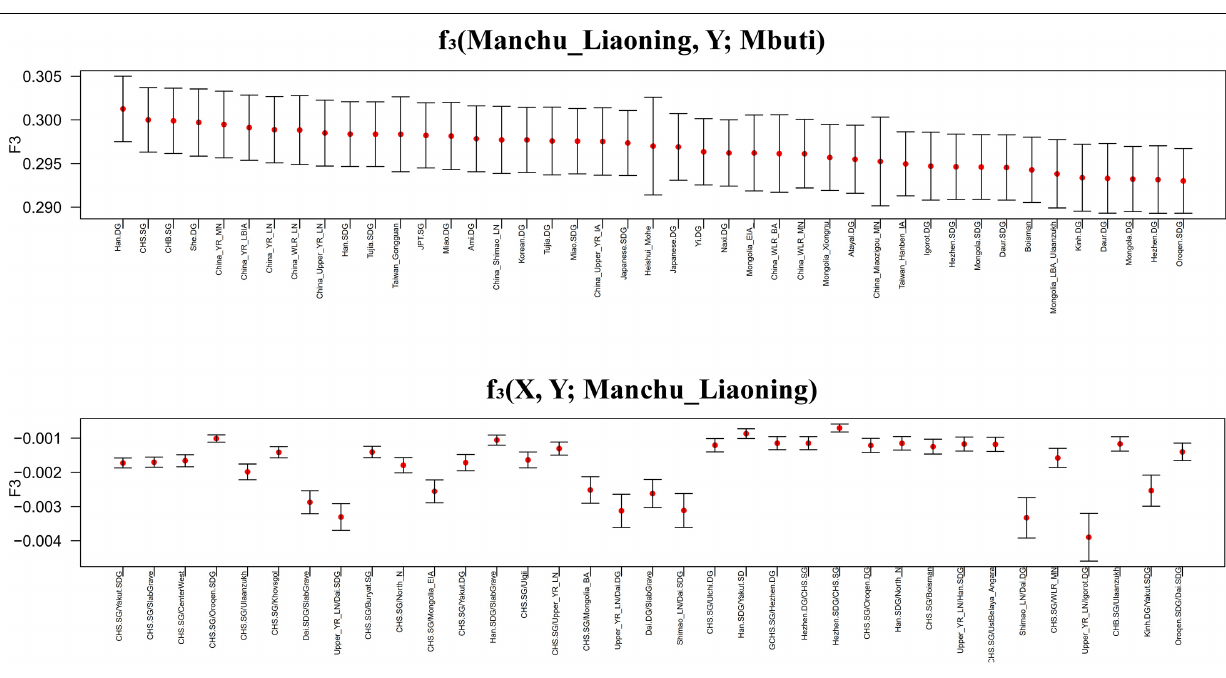
and other reference eastern Eurasians. We found that